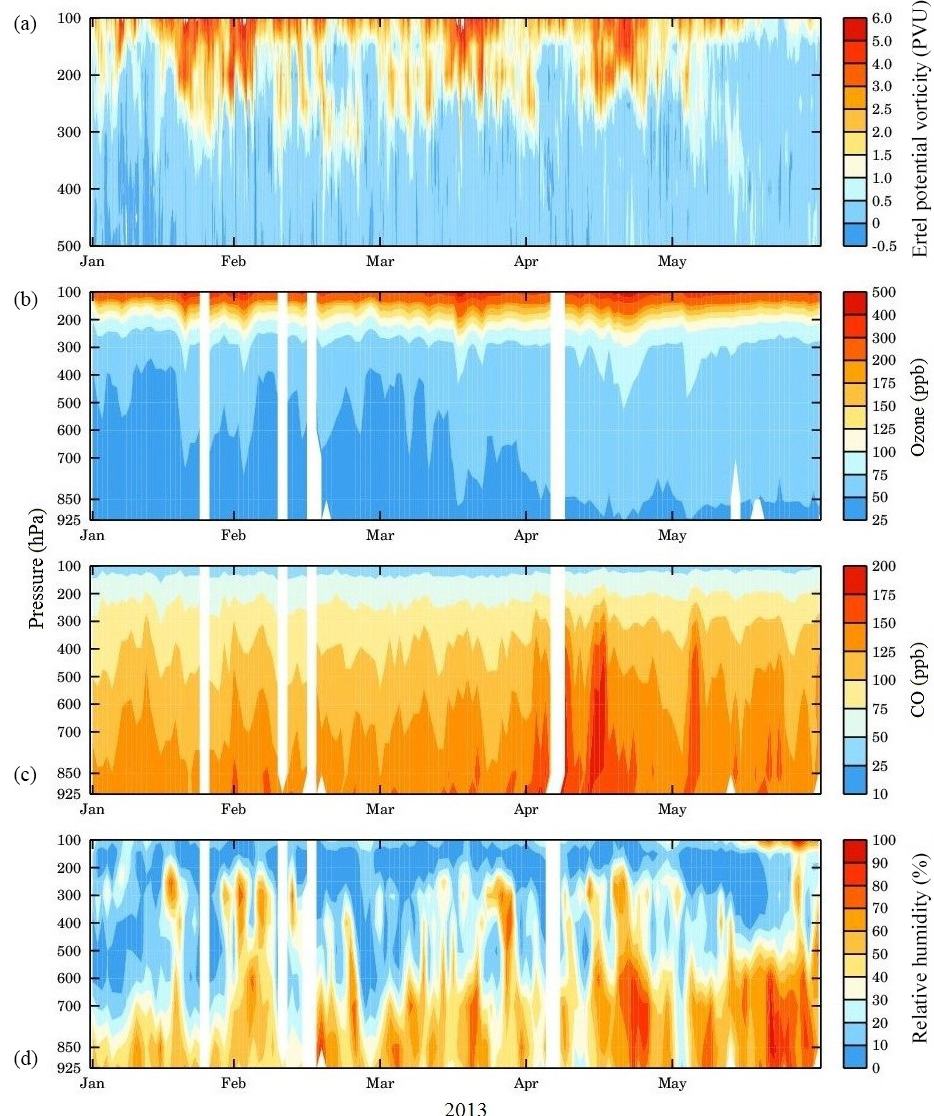
Figure 17. Vertical distribution of Ertel potential vorticity (EPV) calculated by MERRA v2 reanalysis (top), AIRS-retrieved ozone mixing ratios (center), CO mixing ratios (center) and relative humidity (RH) during January–May